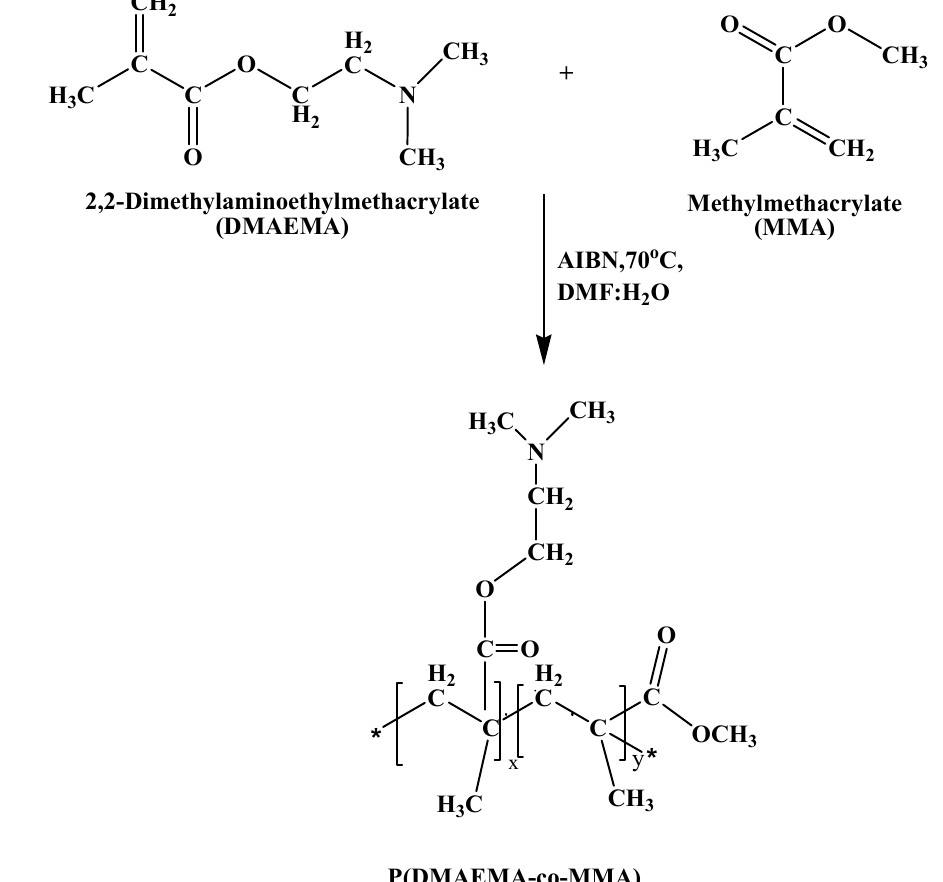
Figure 3. Schematic view of copolymerization reaction between both monomers DMAEMA and MMA.